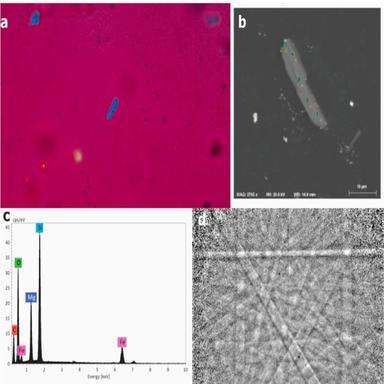
Example of particle extracted from PLM grain mount. Optical micrograph of particle (A) of rarely encountered elongated particle type. (B) backscattered electron micrograph of particle from A (scale bar at bottom right corner is 10 μm). (C) EDS spectrum of particle and (D) electron backscatter diffraction pattern collected from particle consistent with monoclinic amphibole.